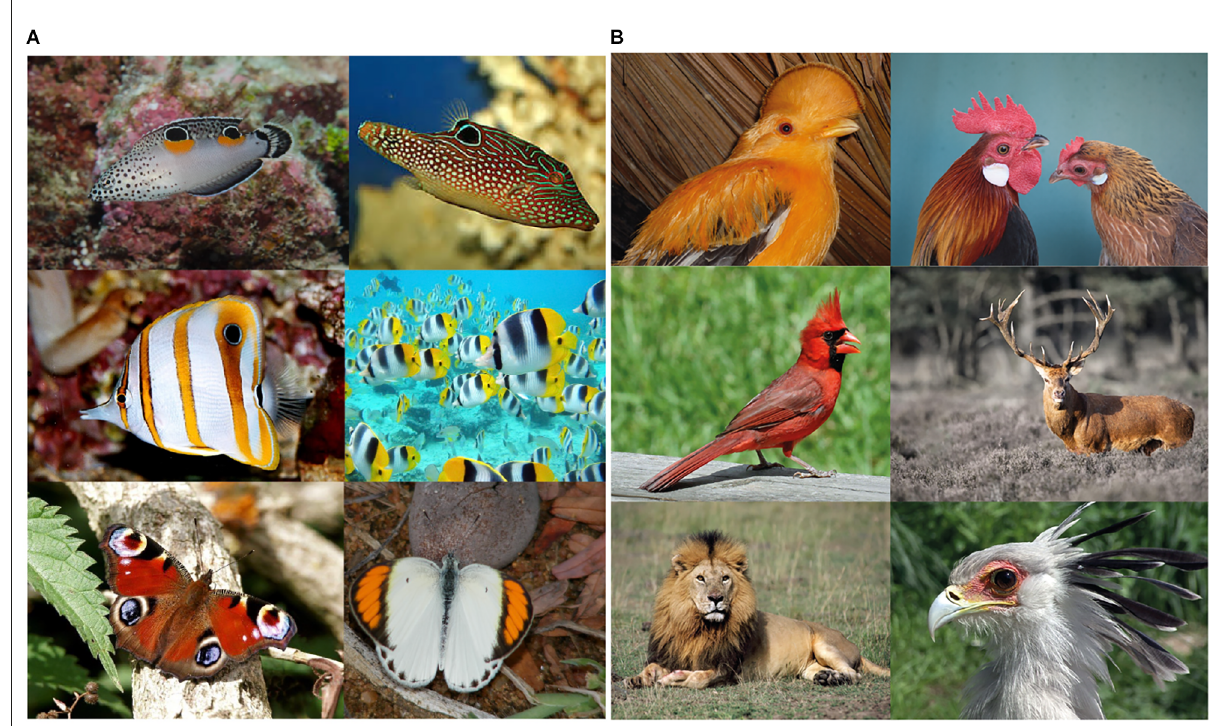
FIGURE15 (A) Dots and spots painted on the livery of animal bodies in order to accentuate a multiplicity of adaptive purposes. (B) Crests, horns, and manes produce illusions for different biological purposes like defense against competitors or predators, courtship and mating, and social status